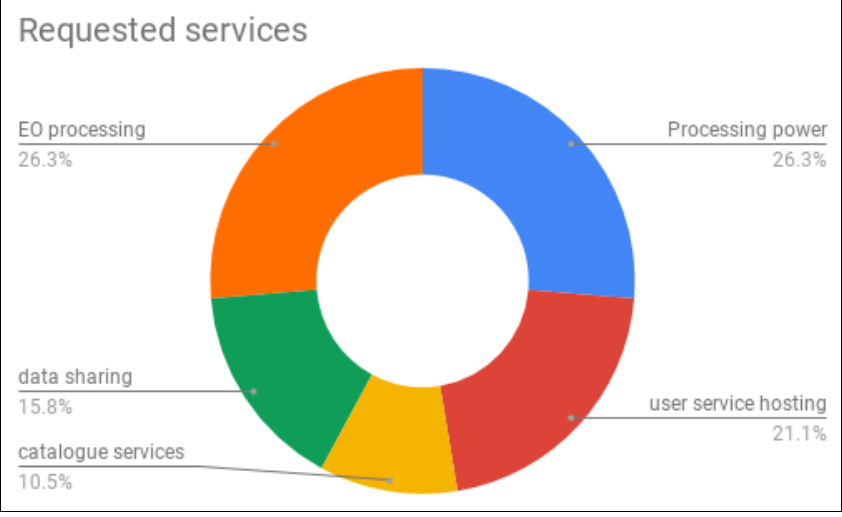
Figure 15. Requested services by the interviewed researchers.